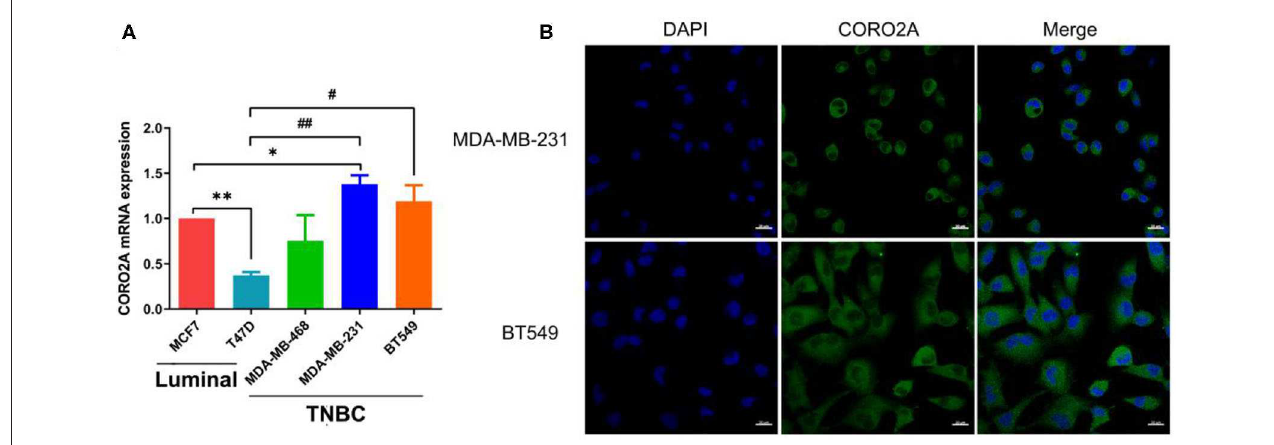
FIGURE 6 | Expression and subcellular localization of CORO2A in breast cancer cells. (A) Relative expression of CORO2A was detected by using qRT-PCR in the luminal (MCF7 and T47D) and TNBC (MDA-MB-468, MDA-MB-231, and BT549) cell lines. Data are mean ± SEM and analyzed using one-way ANOVA. * P < 0.05; ** P < 0.01 compared to MCF7; # P < 0.05; ## P < 0.01 compared to T47D. (B) Subcellular localization of CORO2A was detected in MDA-MB-231 and BT549 cells by immunofluorescence staining. Scale bar, 20 µ m.